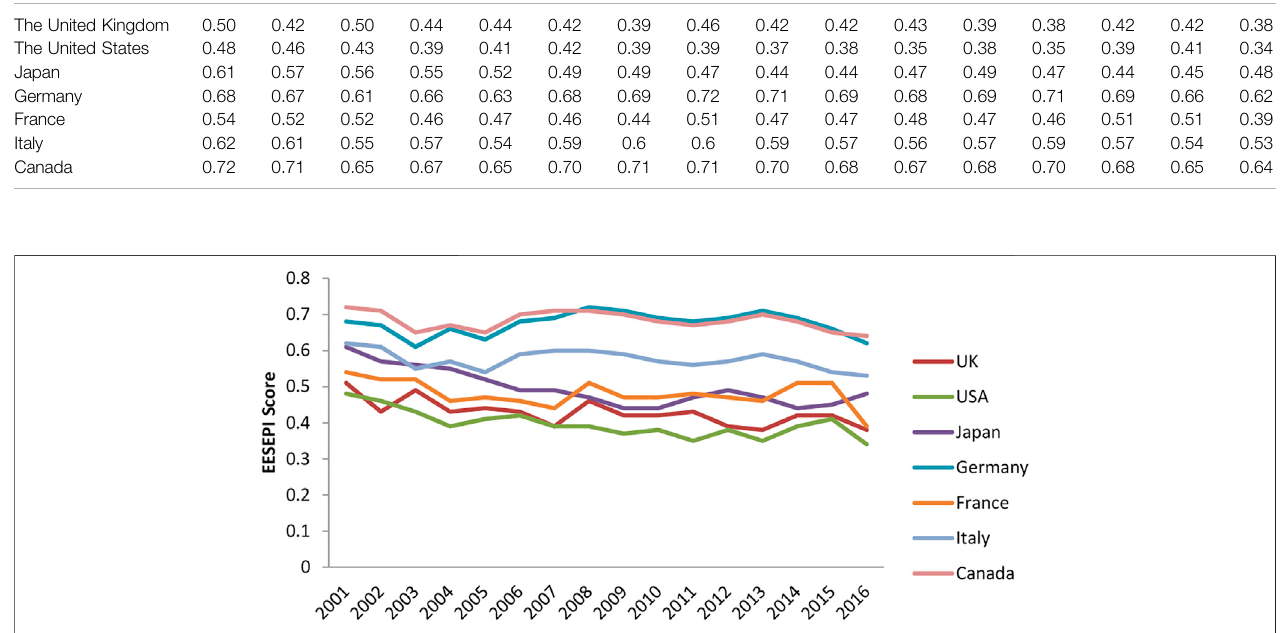
TABLE 3 | Overall composite index score. Country